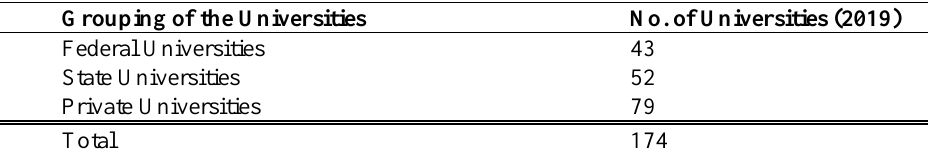
Table 1. The Grouping of the Nigerian Universities (Federal, State and